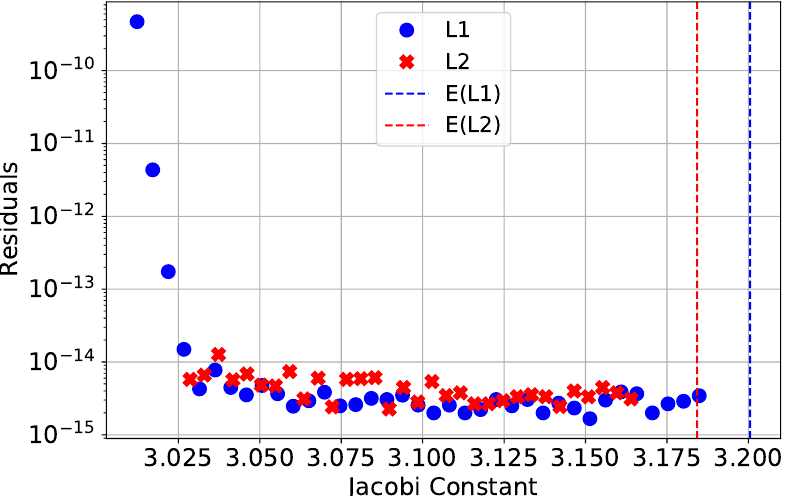
Figure 10. Maximum residuals of the loss vector for the TFC method solving for the trajectories plotted in Figure 9. For almost all cases, the solution accuracy is on the order of O ( 10 − 14 ) . However, around a Jacobi constant level of 3.025, the accuracy decreases for orbits around L1. The solutions for orbits around L2 lower than 3.025 are not plotted because, while they converged to a valid period orbit with high accuracy, it was not a Halo-type orbit.